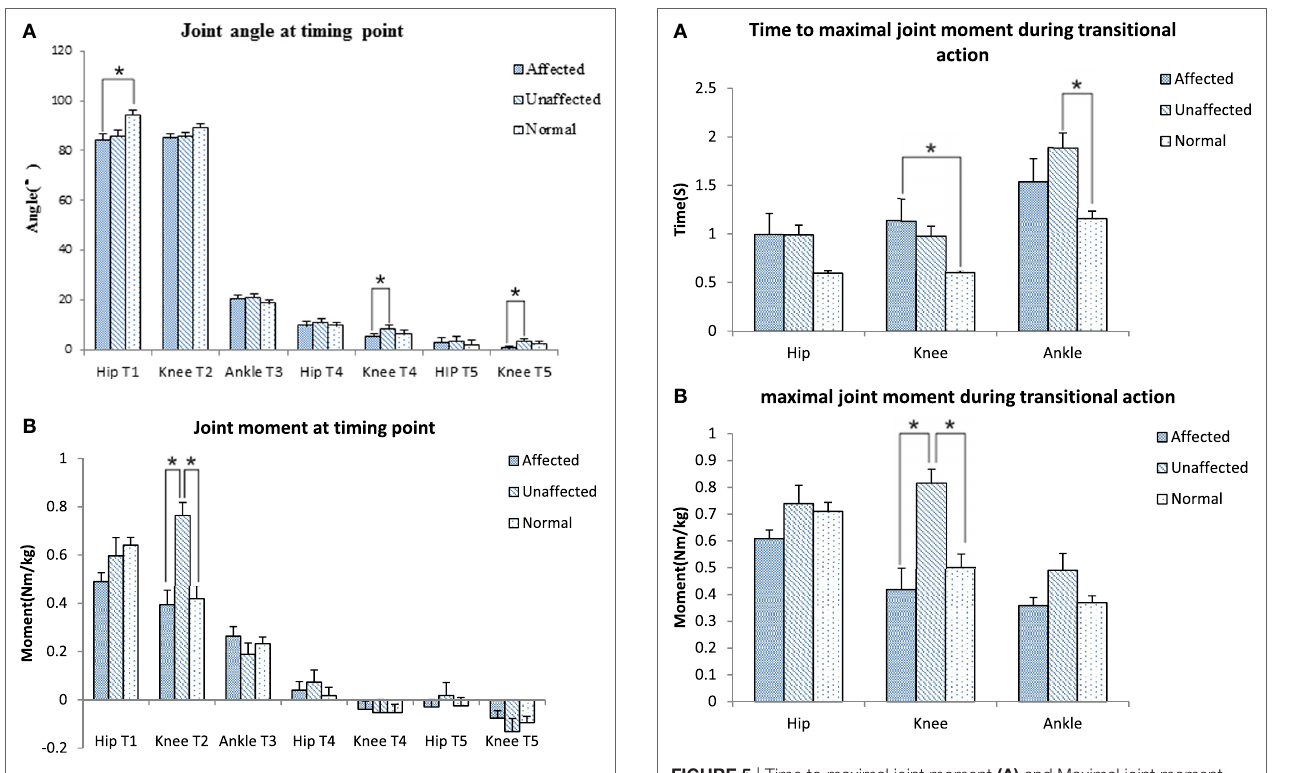
FigUre 4 | Joint angle (a) and joint moment (b) at timing point comparison among the affected, unaffected side of stroke, and healthy controls (* p < 0.05).